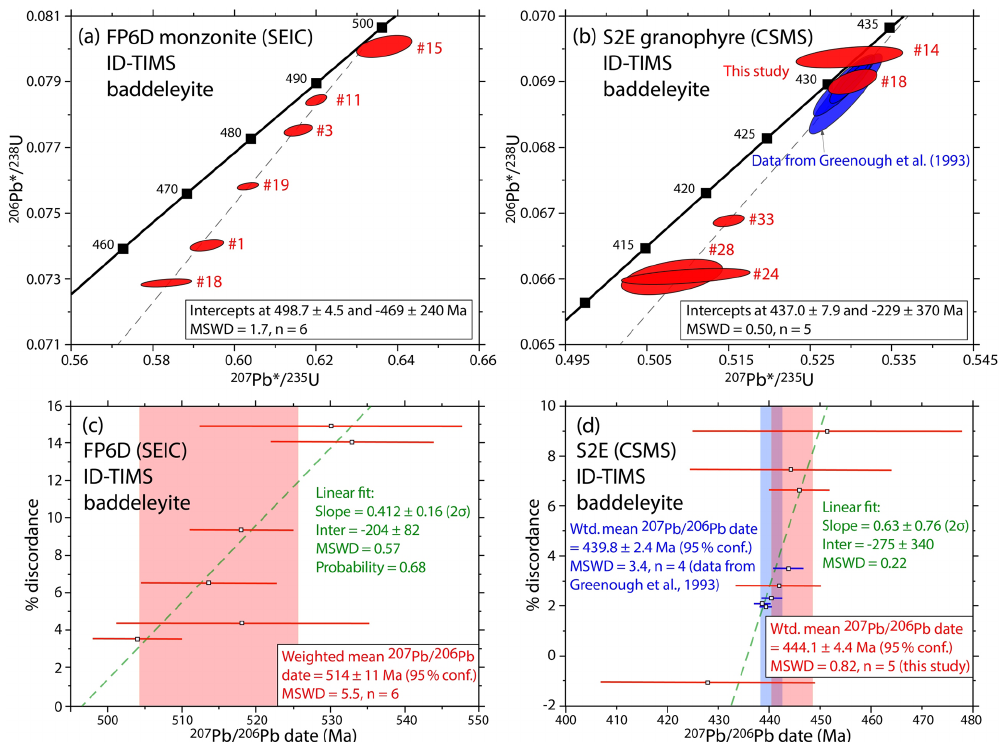
Figure 8. ID-TIMS U–Pb results for samples FP6D and S2E. 207 Pb / 206 Pb dates are less scattered than 206 Pb / 238 U dates but show a linear correlation with the percentage of discordance. All error bars and ellipses represent 2 σ